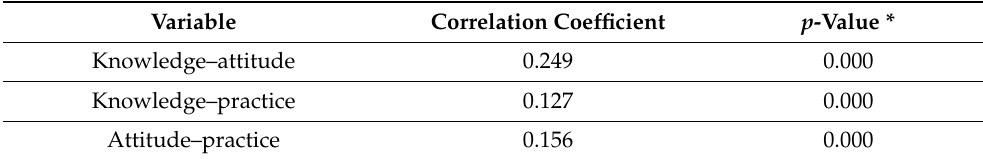
Table 4. Correlations between knowledge, attitudes, and practice scores. Variable Correlation Coefficient p -Value * Knowledge–attitude 0.249 0.000 Knowledge–practice